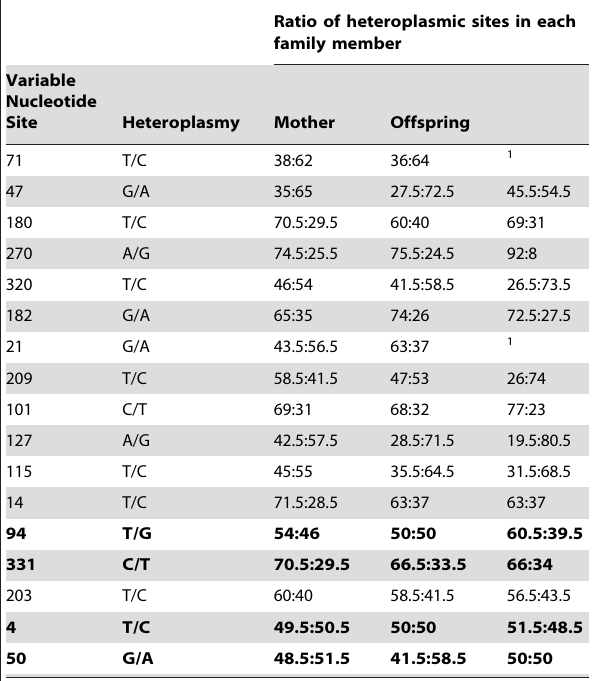
Table 1. Details of heteroplasmies recorded from pedigree material of Ade´lie penguin families.